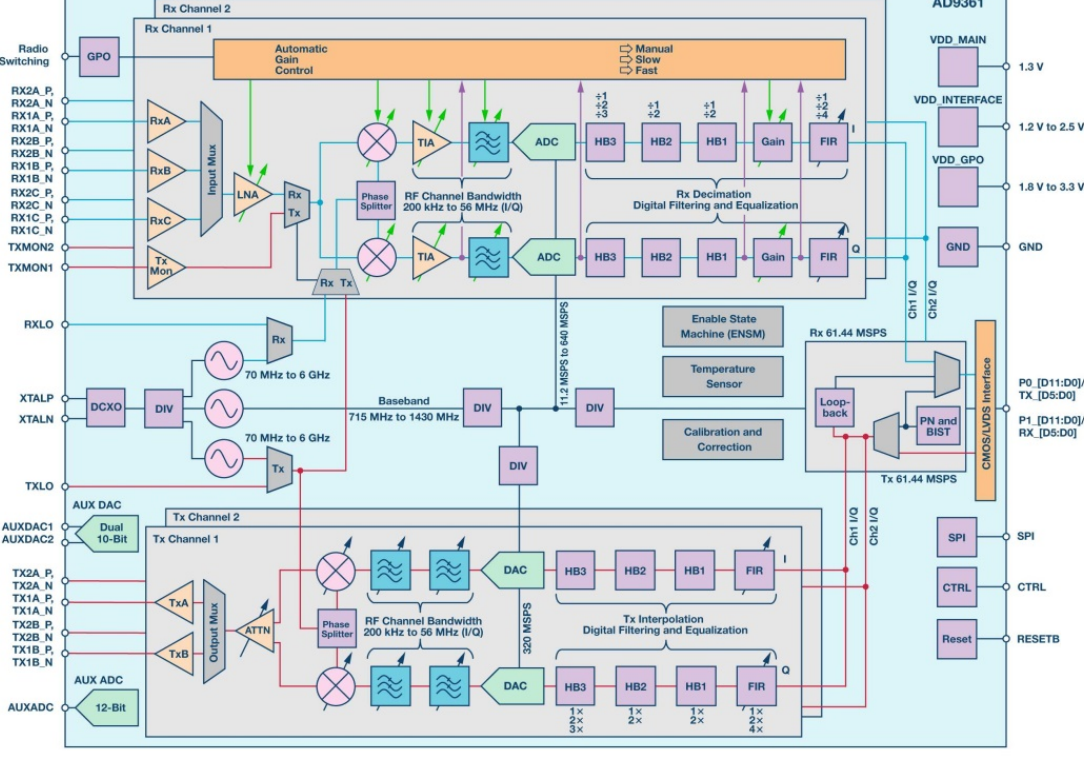
Figure 1. AD9361 functional block diagram [5] .